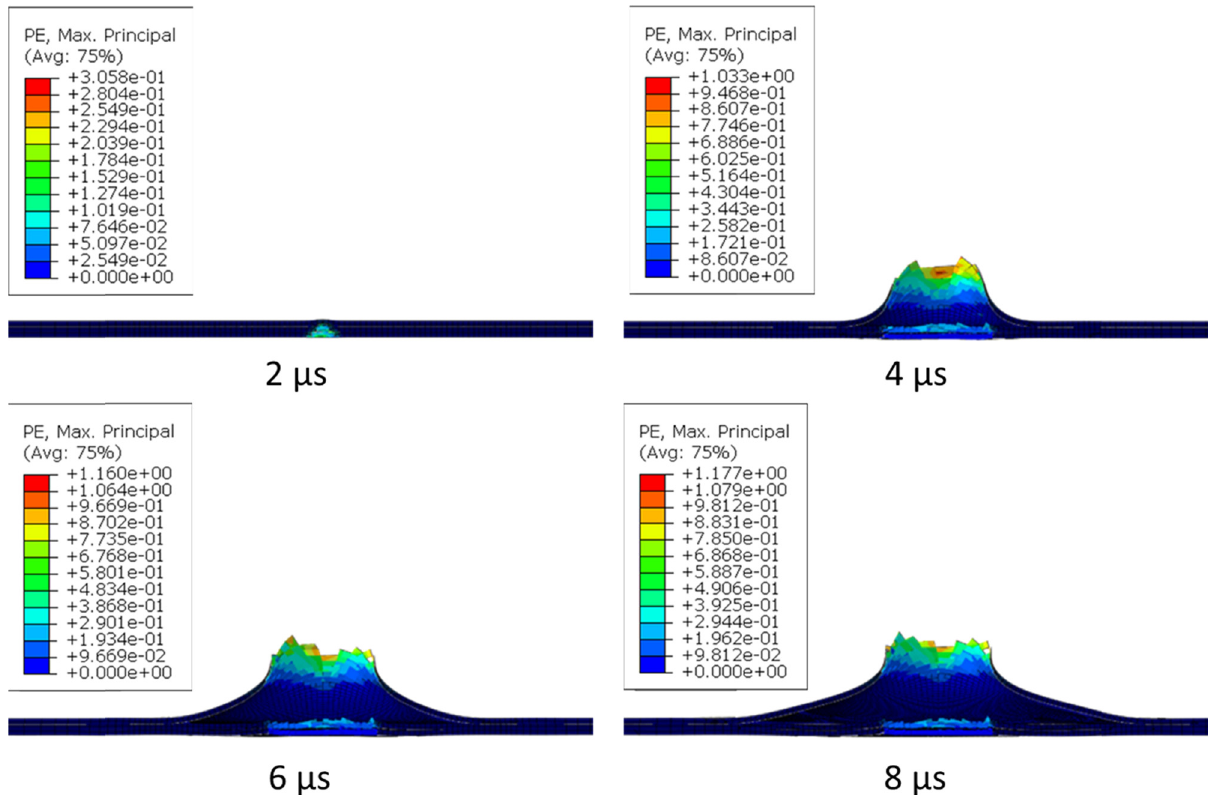
Figure 14: Plastic strain distribution and deformation for model 12 against ogive projectile.